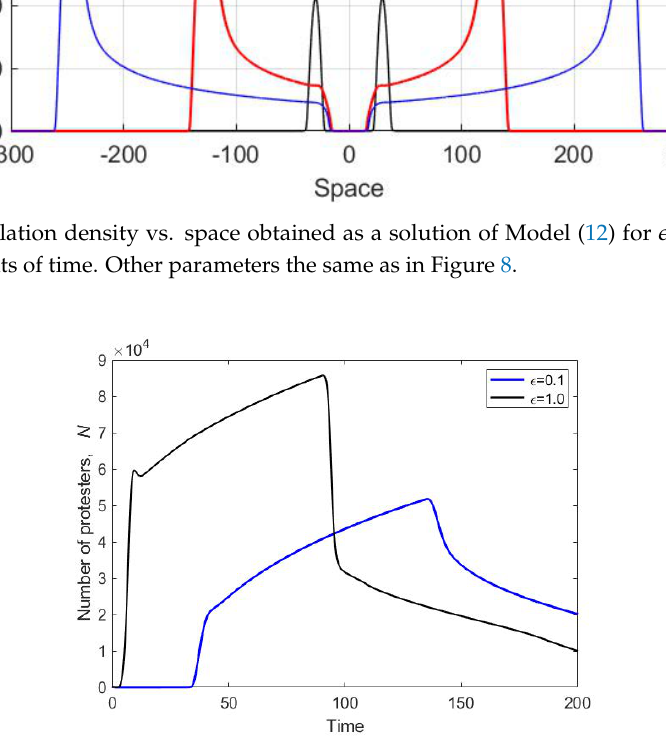
Figure 11. Total number of protesters vs. time as given by the solution of Model (12) and (13) with the initial conditions (14) and (15) obtained for (cid:101) = 1 (black curve) and (cid:101) = 0.1 (blue curve). Other parameters are the same as in Figure